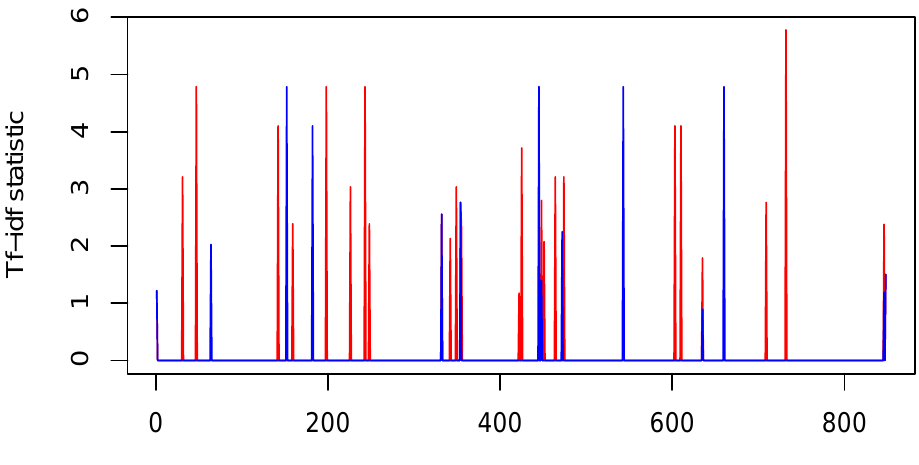
Figure 4. Vectorized representation of text fragments D 1 (red line) and D 7 (blue line) of the training set. Note that parallel coordinates are used. The horizontal axis represents each of the unique words in the training set sorted alphabetically (instead of the word itself, we represent the order number that results from sorting all words alphabetically, so that for example the word “a” is represented by a 1), while the vertical axis shows their tf-idf